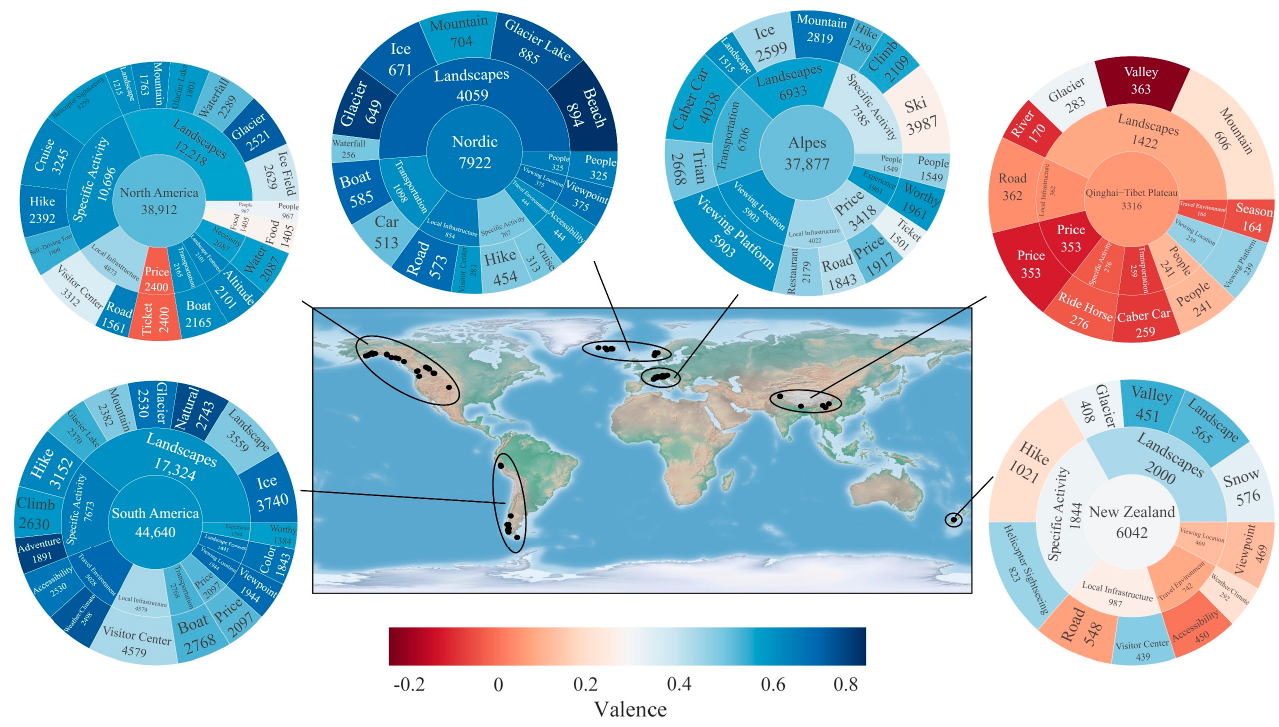
Figure 7. Regional differences in the image of glacier tourism destinations.